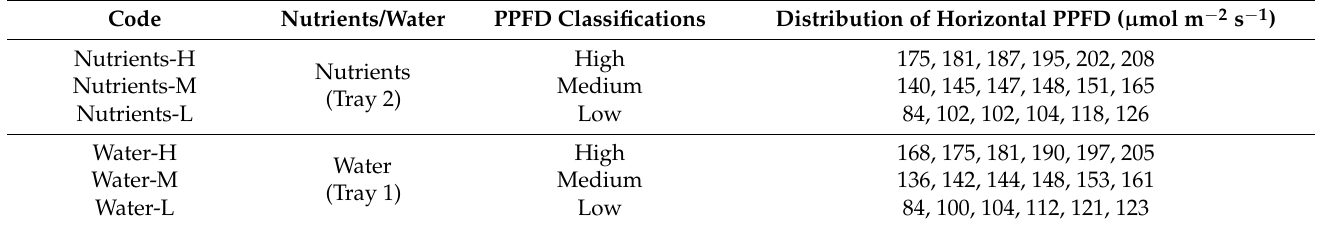
Table 1. Treatments and codes of the experiment. The distributions of horizontal PPFD within the trays (width 605 × length 300 mm) were set for this study. Here, 18 different PPFDs in each tray (Tray 1 with the water and Tray 2 with the nutrients) were categorized into three classifications (6 PPFDs/classification) based on the level of PPFD: low (L), medium (M), and high (H), 84 ≤ 126, 126 < 166, 166 ≤ 208 µ mol m − 2 s − 1 ,